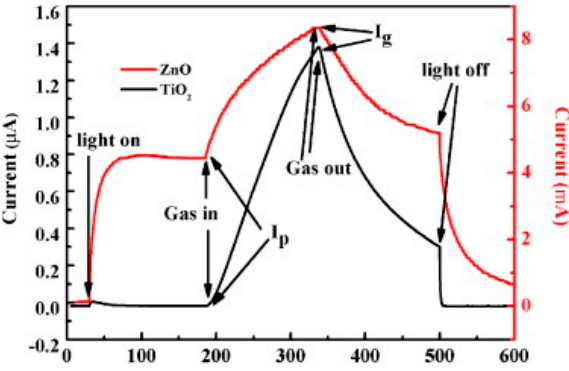
Figure 34. Current transients of TiO 2 and ZnO after exposure to 75 ppm of formaldehyde gas. Reproduced with permission from [64].